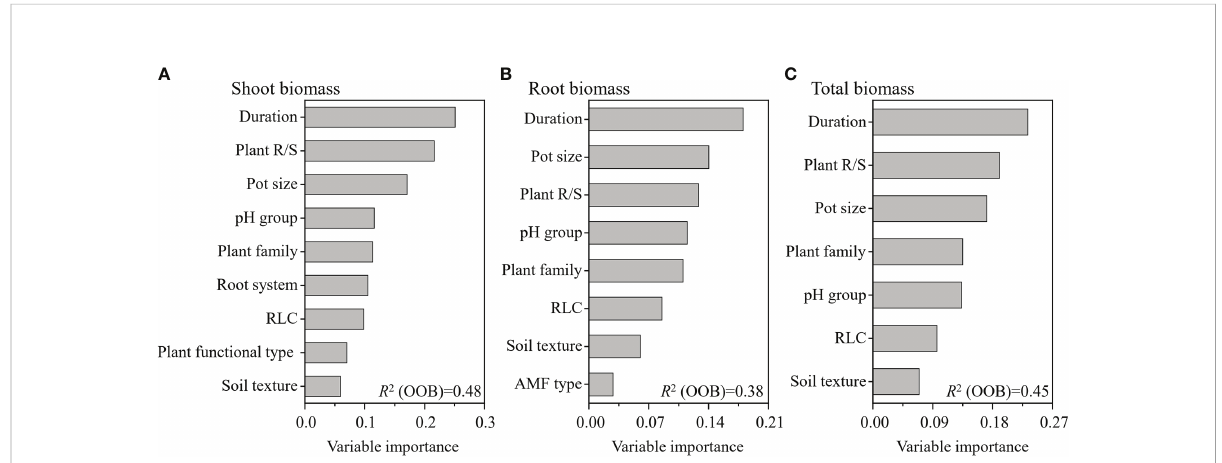
FIGURE 5 Variable importance of the moderators for the effect of arbuscular mycorrhizal fungi (AMF) on plant shoot (A) , root (B) , and total (C) biomass. This weighted random forest analysis included the signi fi cant moderators in the previous random effects